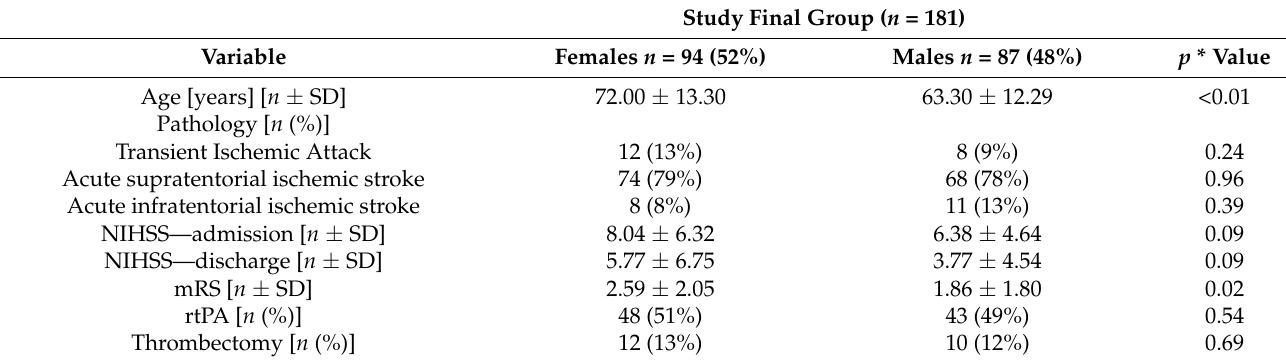
Table 2. Baseline characteristics of men and women in the final group of patients with